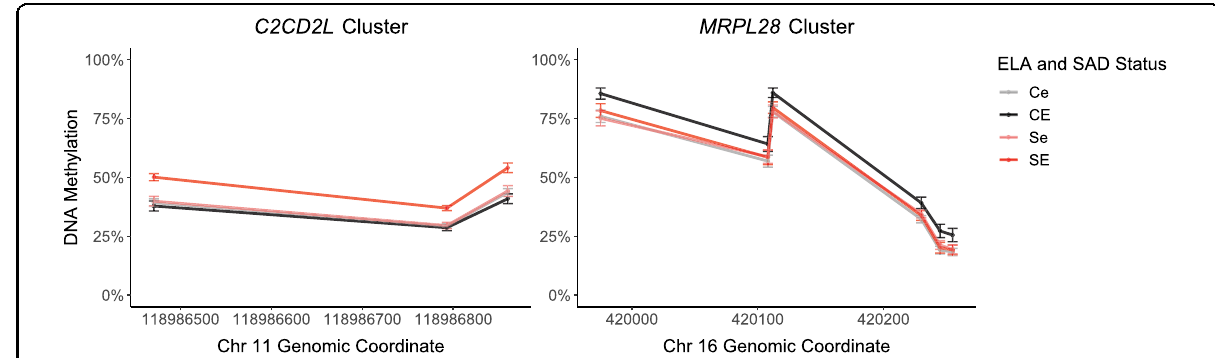
Fig. 3 DMRs with respect to the interaction of SAD and ELA. Group mean DNAm ± standard error within the top two DMRs associated with the interaction of SAD and ELA ( n = 143). Ce control participants with low ELA level, CE control participants with high ELA level, Se participants suffering from SAD with low ELA levels, SE participants suffering from SAD with high ELA